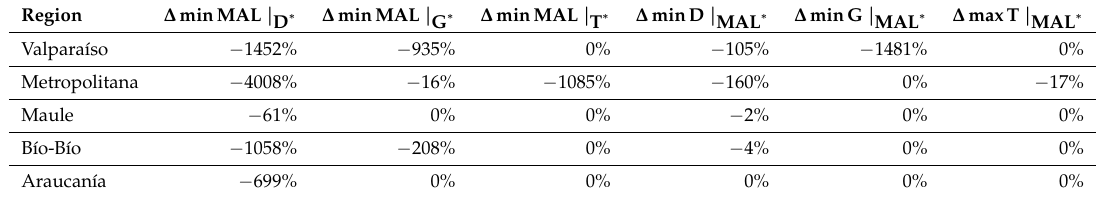
Table 5. Trade-offs of global democratic fairness (in %): Differences when pursuing compactness, global demographic fairness, and local demographic fairness.